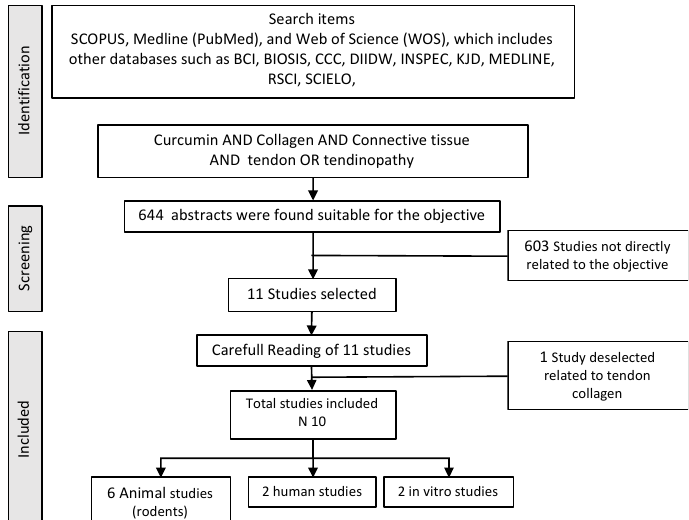
Figure 1. Flowchart used in the bibliographic search.